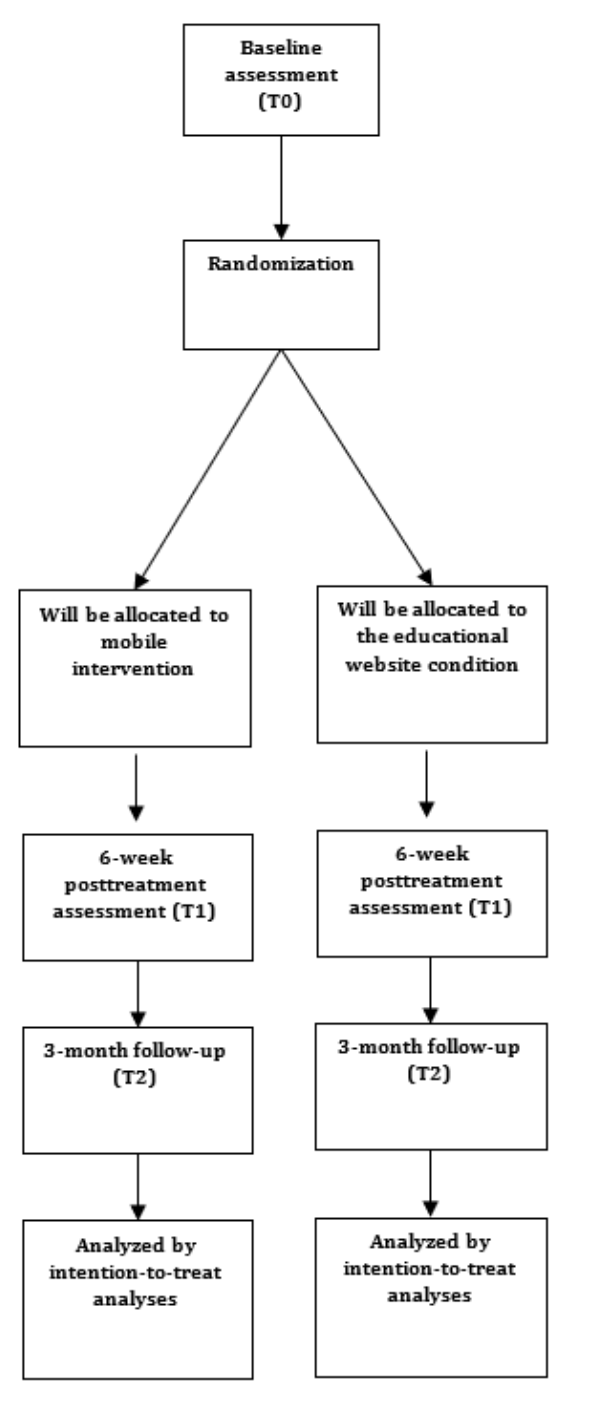
Figure 1. Overview of the participant flow for the randomized controlled